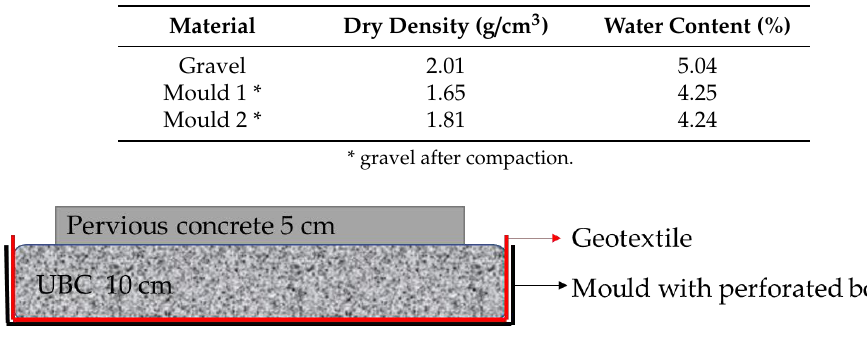
Table 2. Characteristics of unbound base layer - reference material and inbuild in moulds.